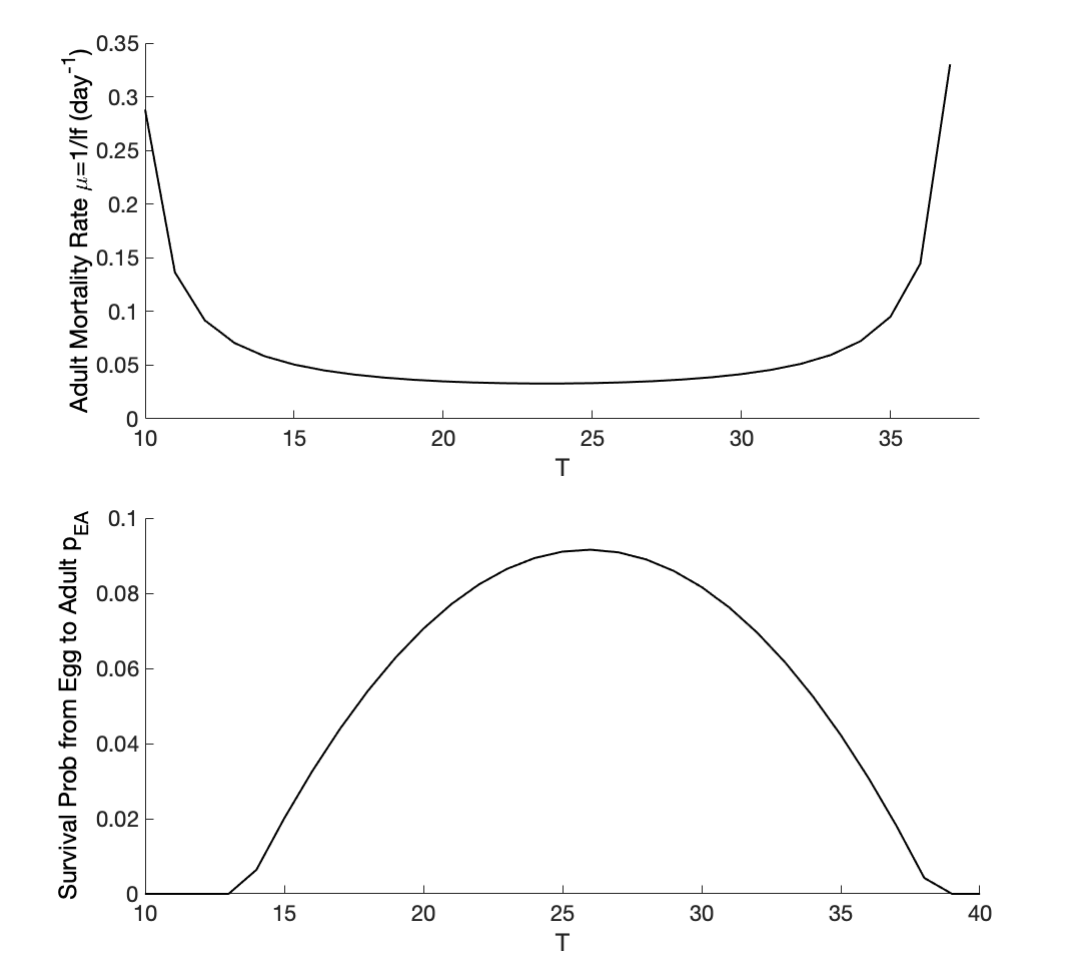
Figure A1. Adult mosquito mortality rate µ and the survival probability from eggs to adult p EA as they vary with the temperature range of 0 ◦ C to 50 ◦ C [24,32].